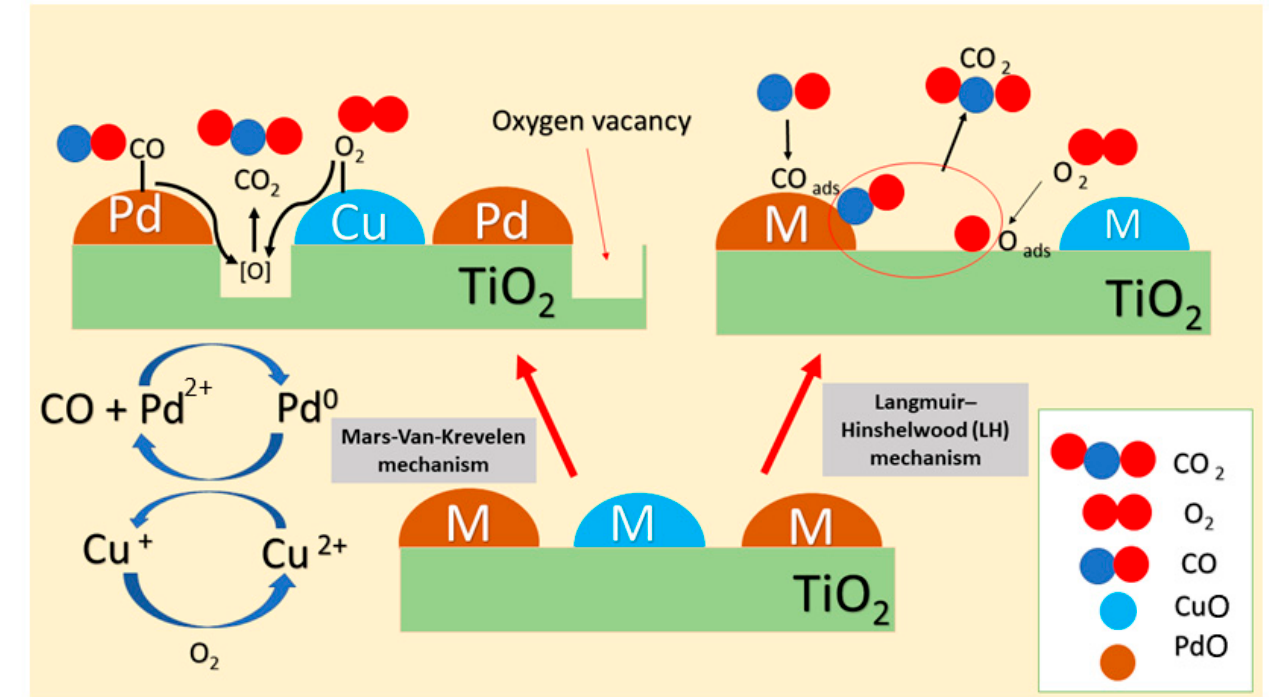
Figure 10. Proposed CO oxidation pathways over Pd-Cu/TiO 2 catalyst.